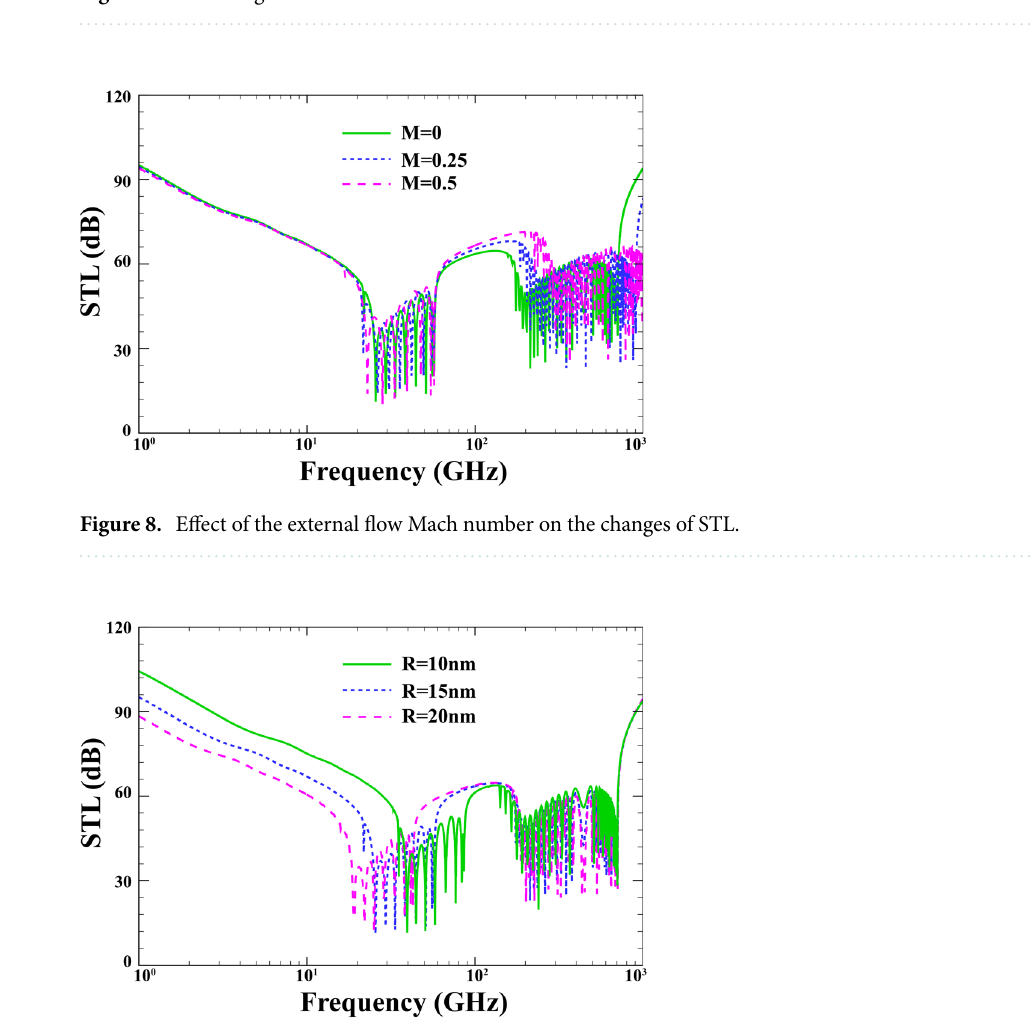
Figure 7. Effect of gradient index on the STL of sandwich FG-PZ nanoshell.